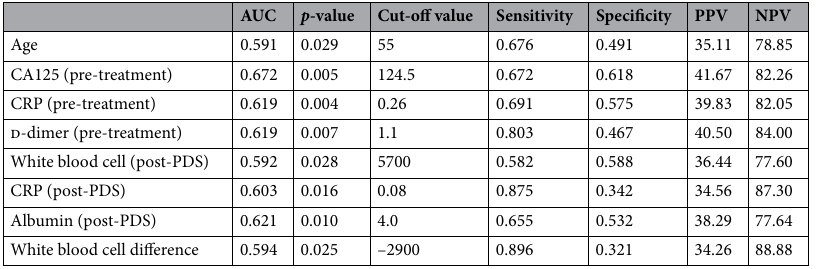
Table 3. The cut-off values predicting recurrence. CA125 carbohydrate antigen125, CRP C-reactive protein, Hb hemoglobin, PDS primary debulking surgery, PPV positive predictive value, NPV negative predictive value, AUC area under curve.